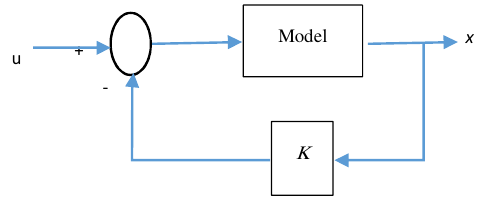
Fig. 2. Block diagram of LQR